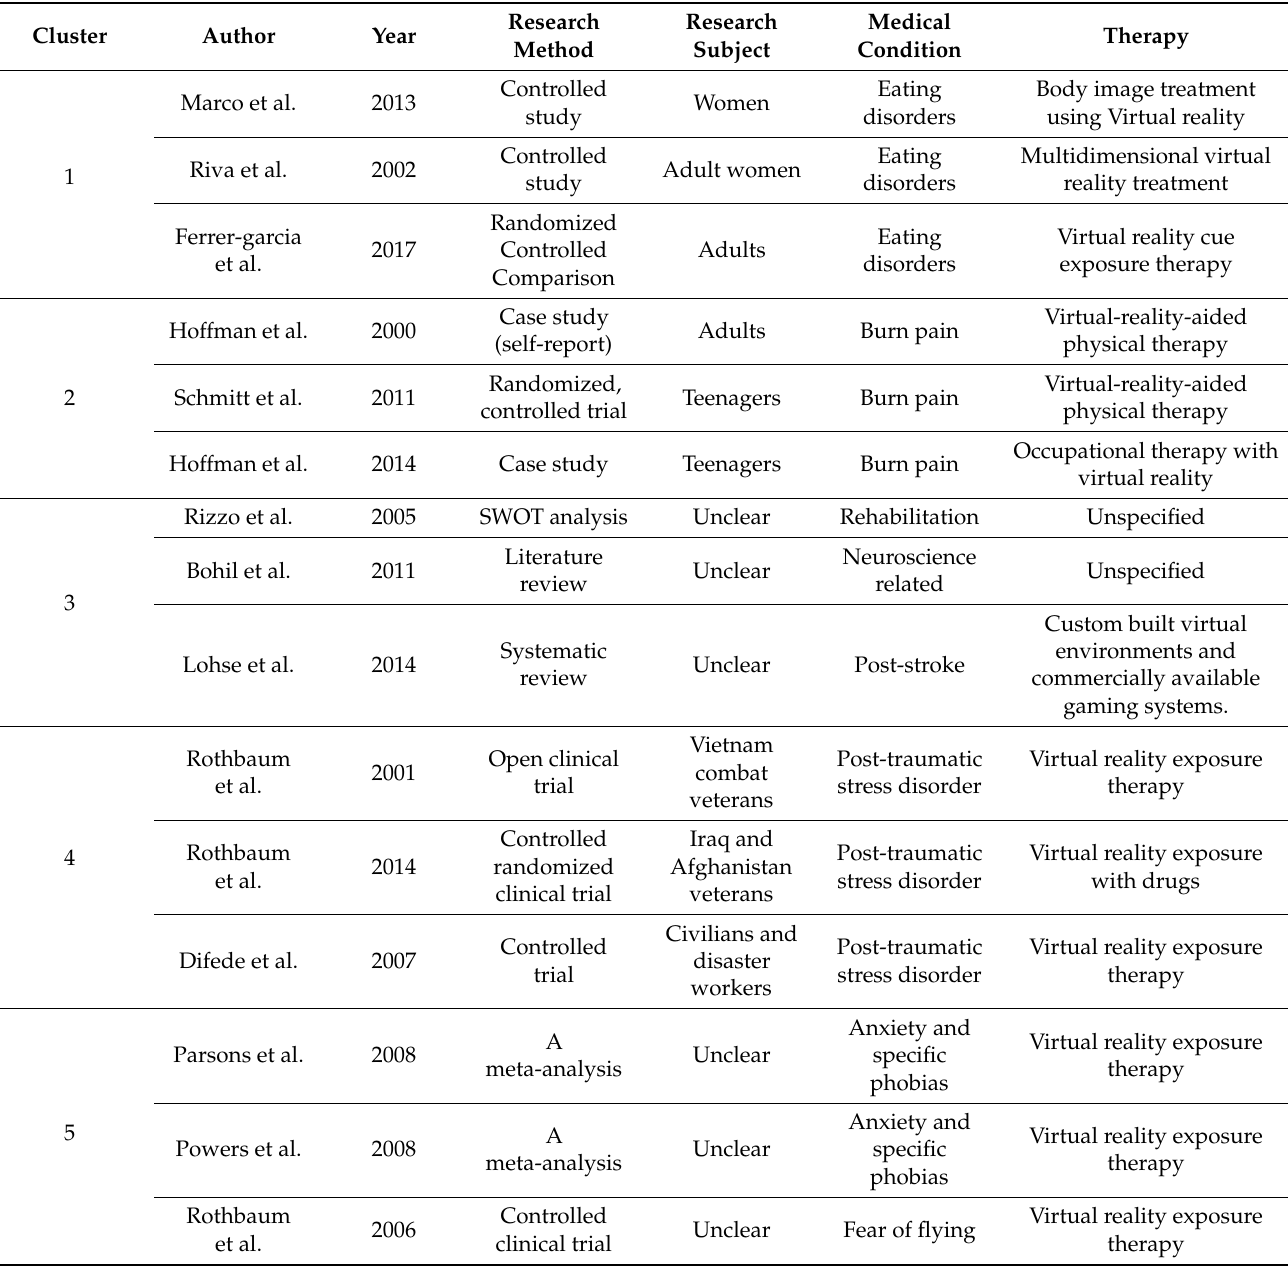
Table 1. The representative articles of each cluster in Figure 2 for virtual reality (VR) aided therapy (devised by the